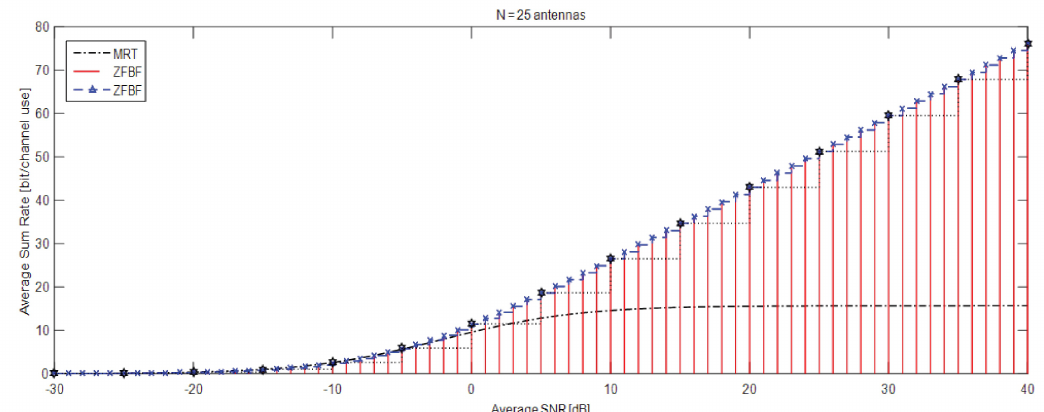
Figure 3. Performance of Transmit MMSE, MRT and ZFBF with antennas N = 25. ZFBF and MRT compensate against average SNR and user function SNR shows that high SNR limit the interuser interface and ZFBF compensate with transmit MMSE and increase with densification of network antennas.